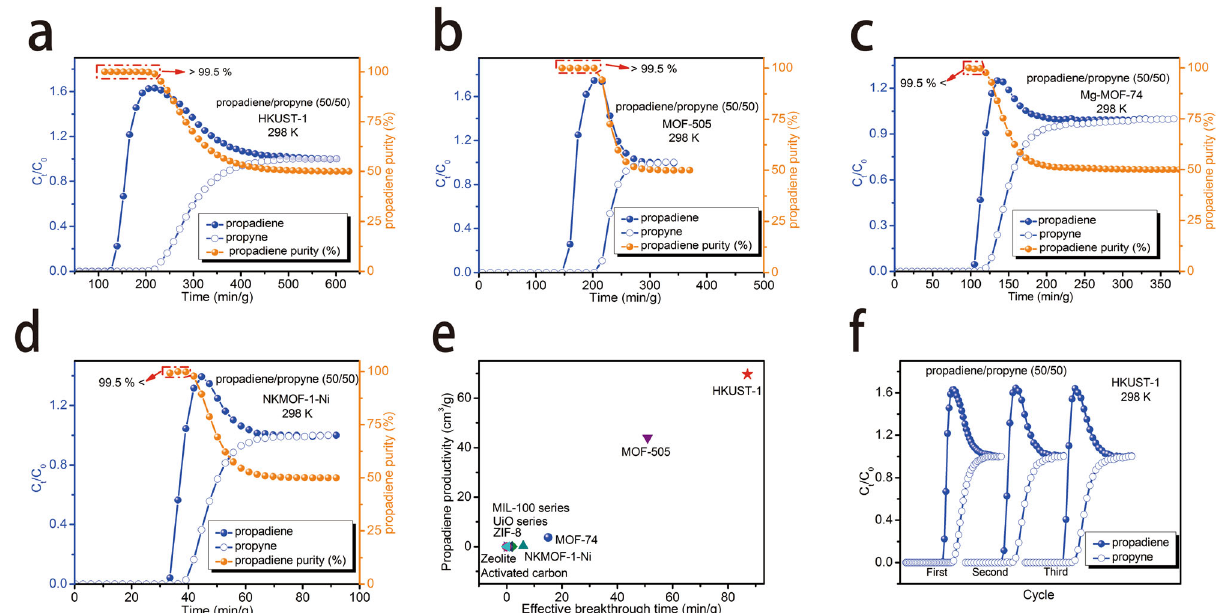
Fig. 4 Experimental breakthrough curves of the MOFs with OMSs for propyne/propadiene (50/50, v/v) separation at 298 K. a HKUST-1. b MOF-505. c Mg-MOF-74. d NKMOF-1-Ni. e Comparing productivity of propadiene for corresponding breakthrough experiments in the adsorbent library. f Cycling tests of HKUST-1 for propyne/propadiene mixture (gas velocity: 2.0